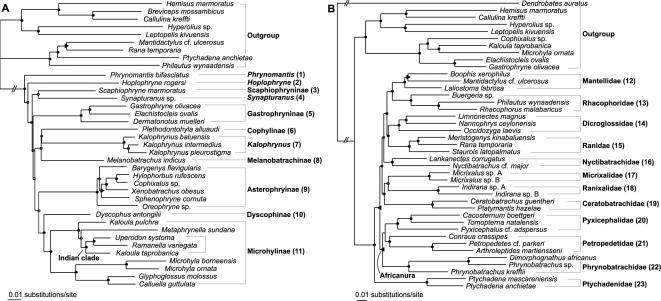
Maximum likelihood phylograms for (A) Microhylidae (-lnL = 24126.41696) and (B) Natatanura (-lnL = 53106.71363). Branch support is indicated as follows: black circles: ML bootstrap support (BS)≥75% and Bayesian posterior probability (PP)≥0.95; triangle pointing to the right: BS<75%, PP≥0.95; triangle pointing to the left: BS≥75%, PP<0.95; white circles: BS<75% and PP<0.95.Higher taxon names follow Frost et al. [13], with the exception of removal of Hoplophryne from Melanobatrachinae, and recognition of Ranixalidae.